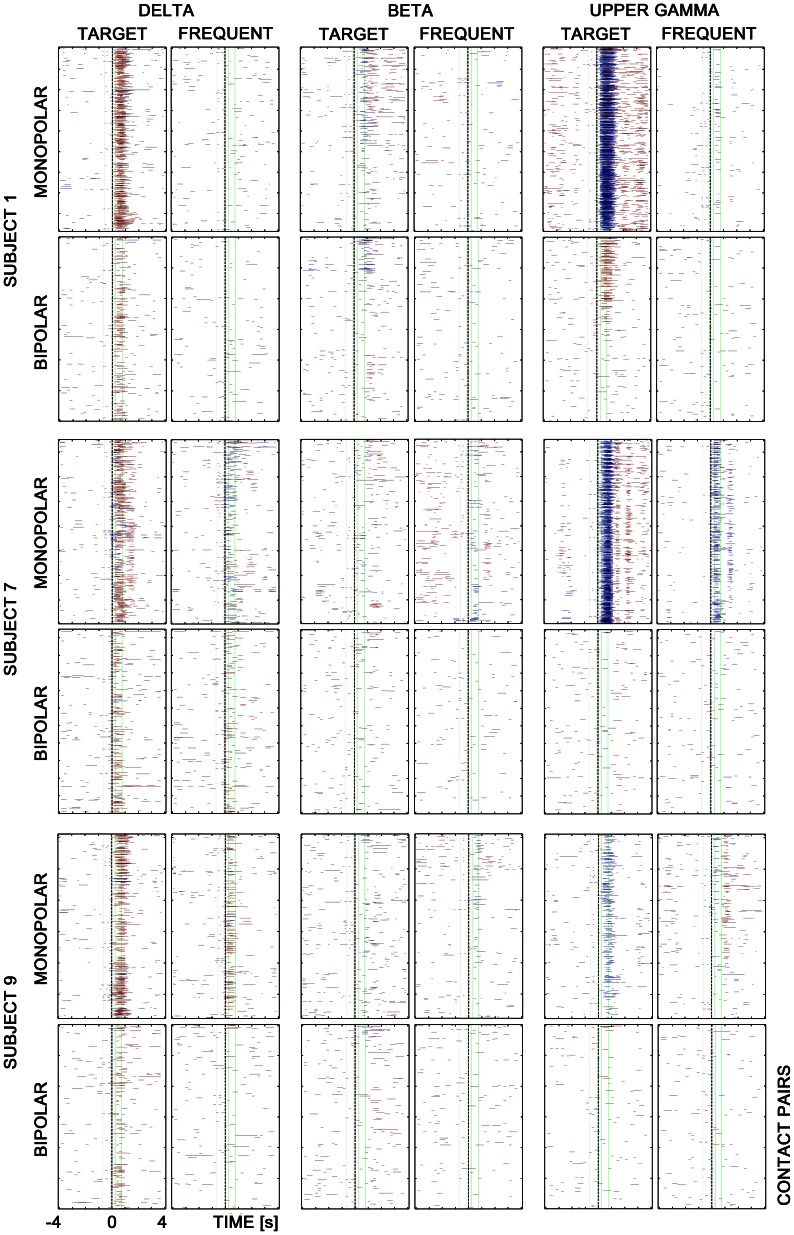
Matrices with significant correlation changes in three subjects; three frequency bands – δ (2–4 Hz), β (12–20 Hz), and upper γ (55–95 Hz), and two different stimuli – targets vs.frequents, for monopolar and bipolar montages.The correlation increase is highlighted in red, decrease in blue. Each colored line corresponds to changes in a contact pair in time (notice all pairs of investigated subject’s contacts are represented in individual matrices for each patient). Green vertical lines define interval 250–750 ms after stimuli.